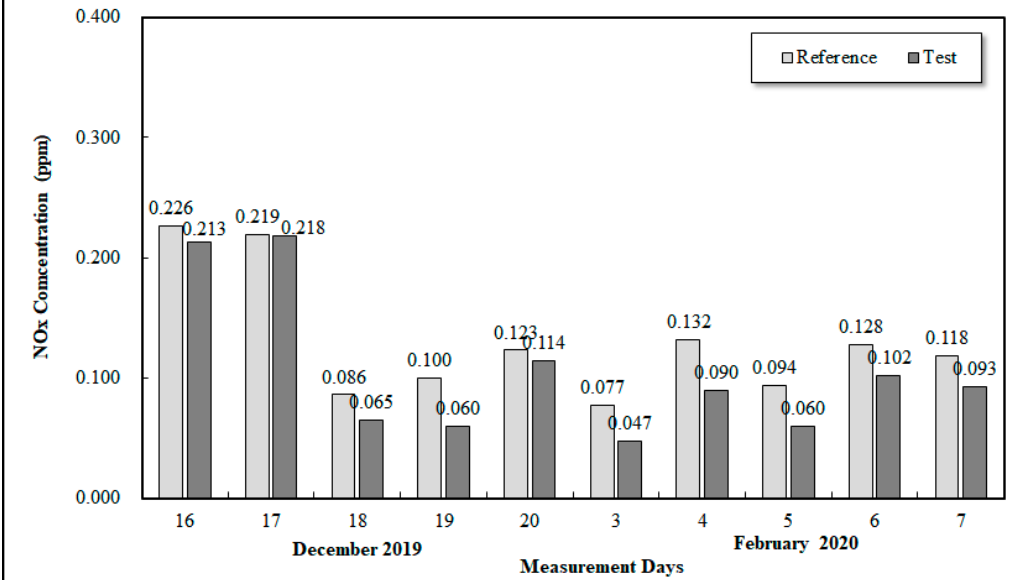
Table 4. Analysis Results of Characteristics of NOx in the Test and Reference Section.